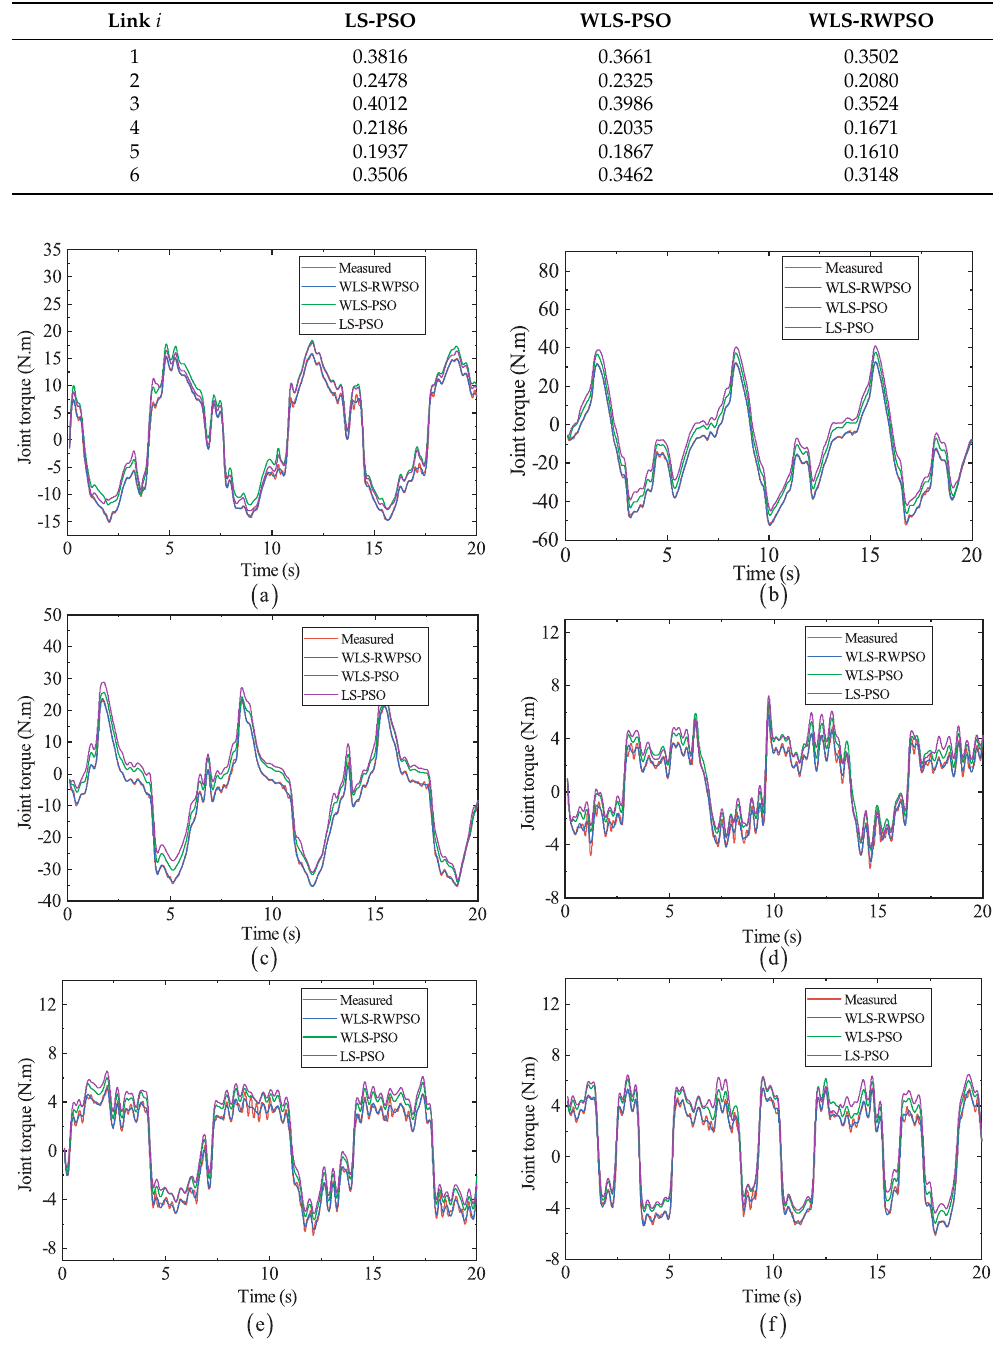
Figure 6. Joint moments of collaborative robots predicted by different algorithms. ( a ) Predicted torque of joint 1 by identification. ( b ) Predicted torque of joint 2 by identification. ( c ) Predicted torque of joint 3 by identification. ( d ) Predicted torque of joint 4 by identification. ( e ) Predicted torque of joint 5 by identification. ( f ) Predicted torque of joint 6 by